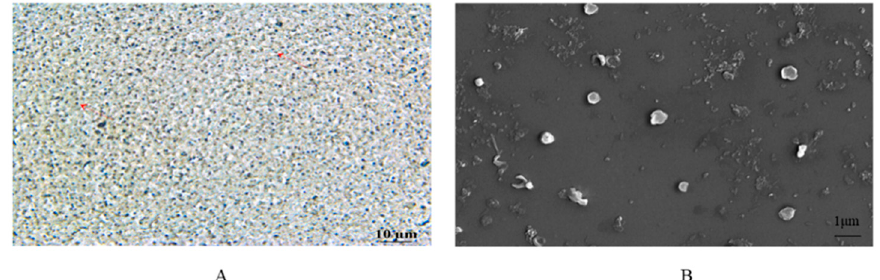
Figure 3. ( A ) Optical microscopy (magnification 40×) and ( B ) scanning electron microscopy (magni- fication 10,000×) photographs of the TA-SLN suspension.